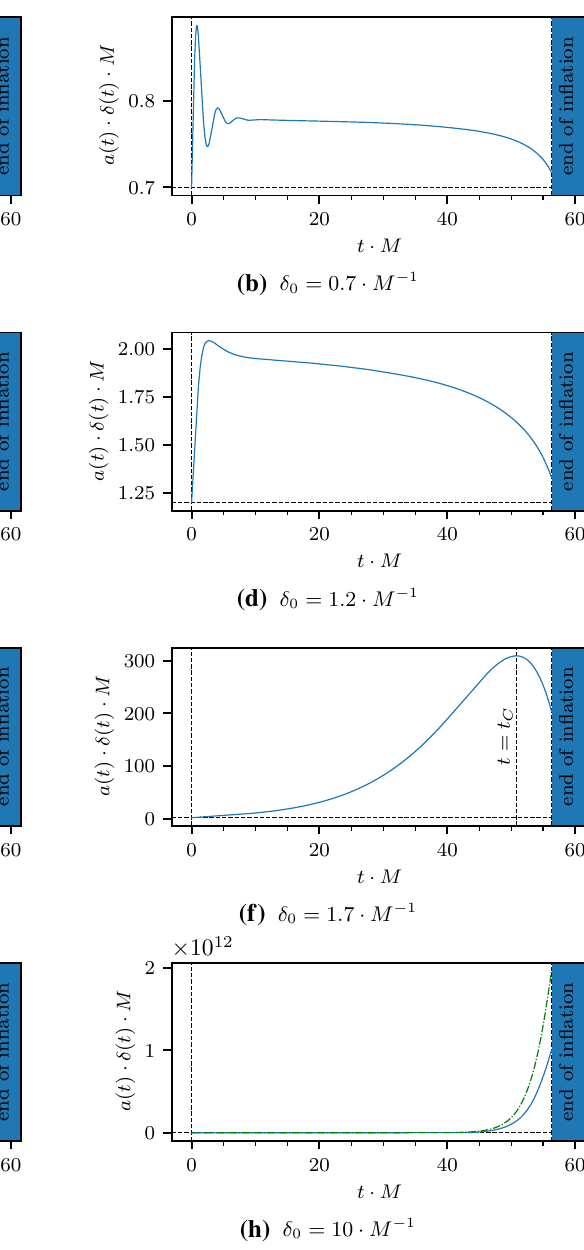
Fig. 7 Time dependence of physical thickness of the wall, a ( t ) · δ( t ) , for different values of the initial wall thickness, δ 0 , in the R 2 -inflation. Here t , a ( t )δ( t ) and δ 0 are shown in M − 1 units. Dashed horizontal line corresponds to δ 0 . The time at which the inflation ends is shown by ver-